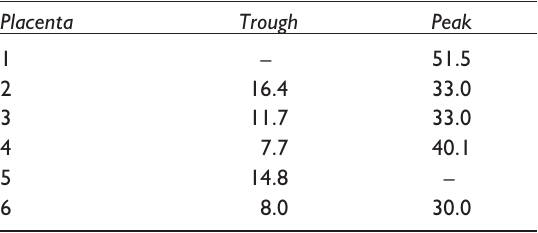
Table 1 Mean vancomycin concentrations ( m g/ml), troughs and peaks, in placentas 1 –6 Placenta Trough Peak